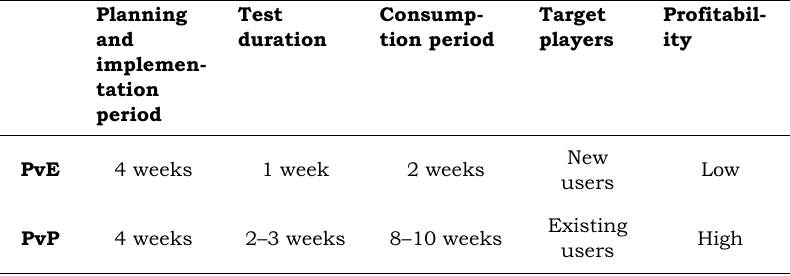
Table 1. Product configuration of project A